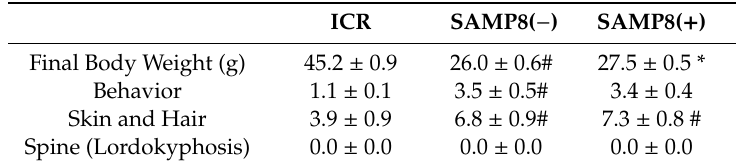
Table 2. E ff ects of Coriandrum sativum seed extract on the final body weight and appearance change in ICR and senescence-accelerated mouse-prone 8 (SAMP8)